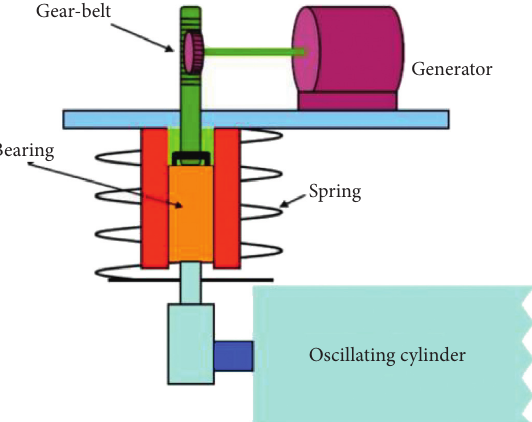
Figure 3: The VIVACE configuration proposed by Bernitsas et al. [35].